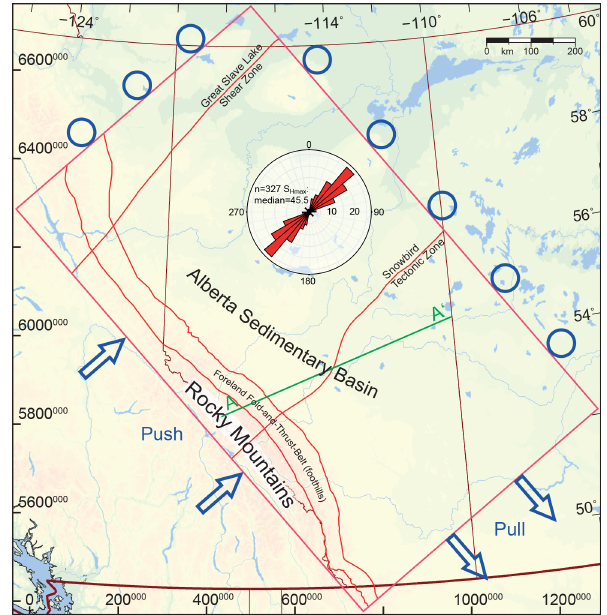
Figure 4. Map of Alberta with the model extent (red box) combined with the model features. Implemented are the main structural fea- tures (red lines), which are the front of the Rocky Mountains and the foothills, respectively, as well as the Snowbird Tectonic Zone and the Great Slave Lake Shear Zone. For comparison, see the tec- tonic map (Fig. 2). Push and pull along model sides and the allowed lateral motion are indicated by blue arrows and circles, respectively. The mean orientation of S Hmax is indicated by a rose diagram; note that stress orientation is parallel and orthogonal, respectively, to the model box. The trace of the cross section in Fig. 3 is indicated by the green